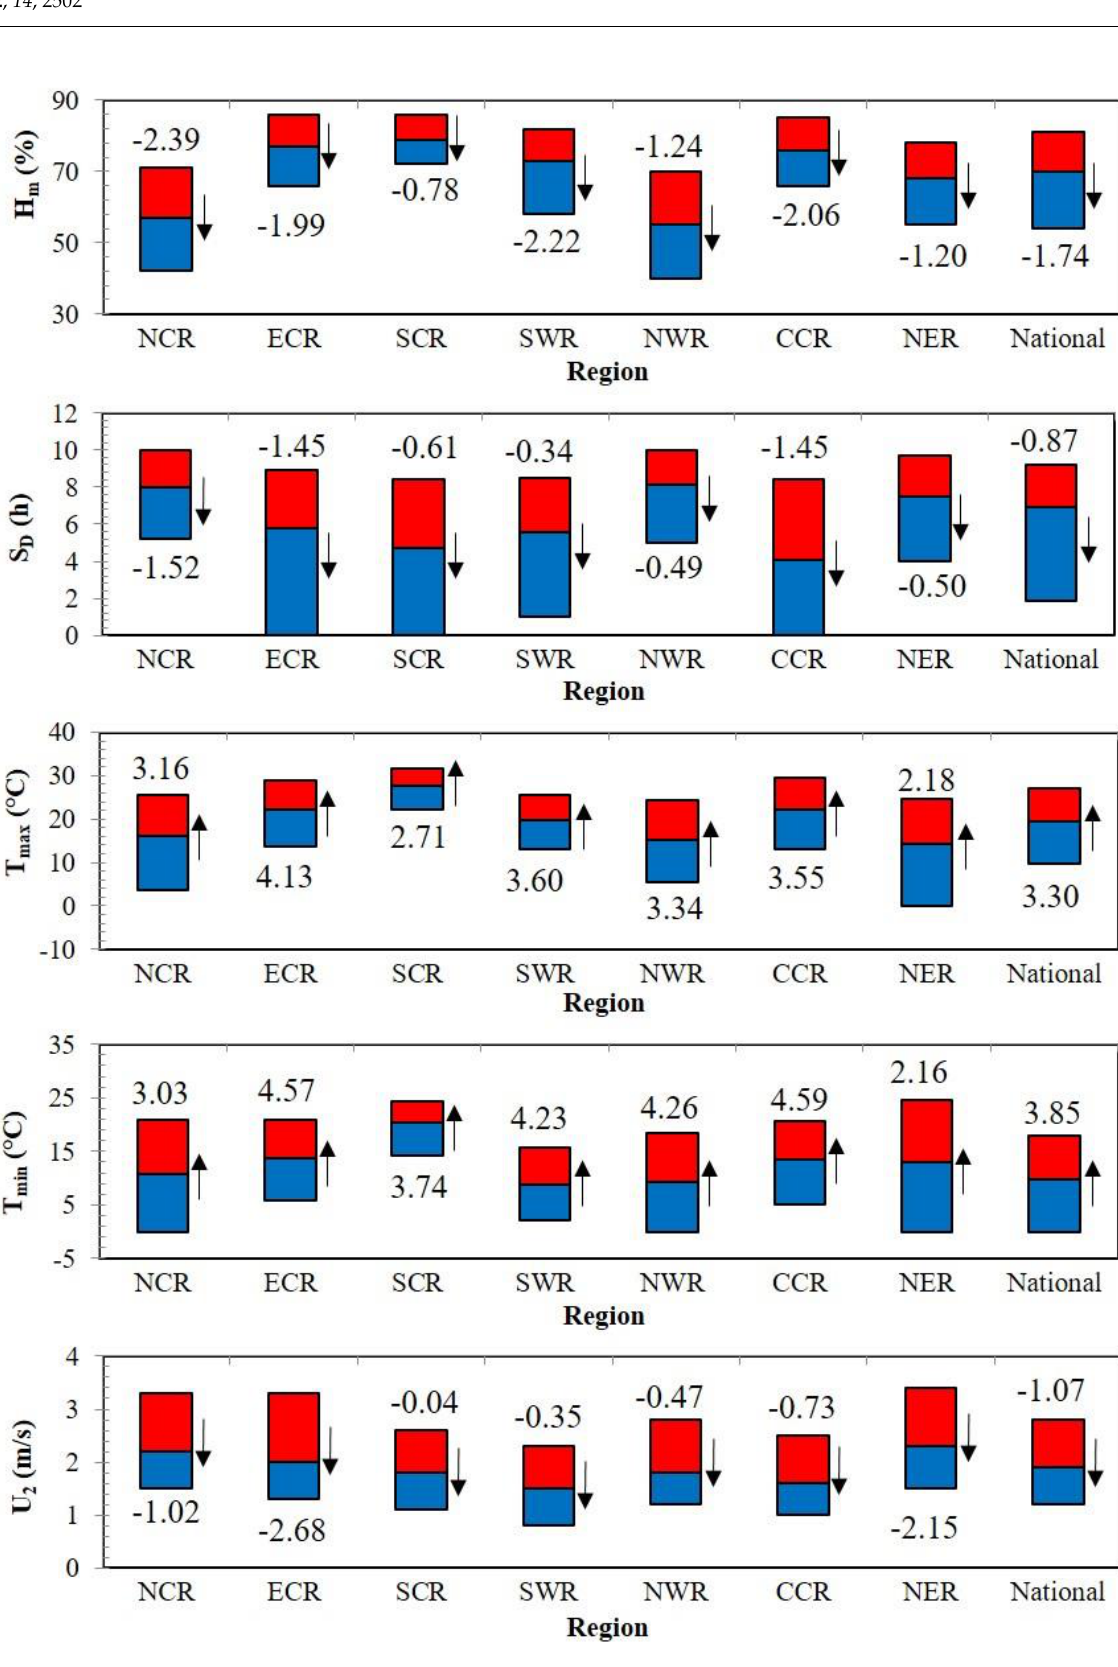
Figure 8. Statistics of the climatic factors in different subregions. The lower line = the lower quartile; the medium line = the middle values; the upper line = the upper quartile; the arrow = the trend; and the numbers = the values of Z s .